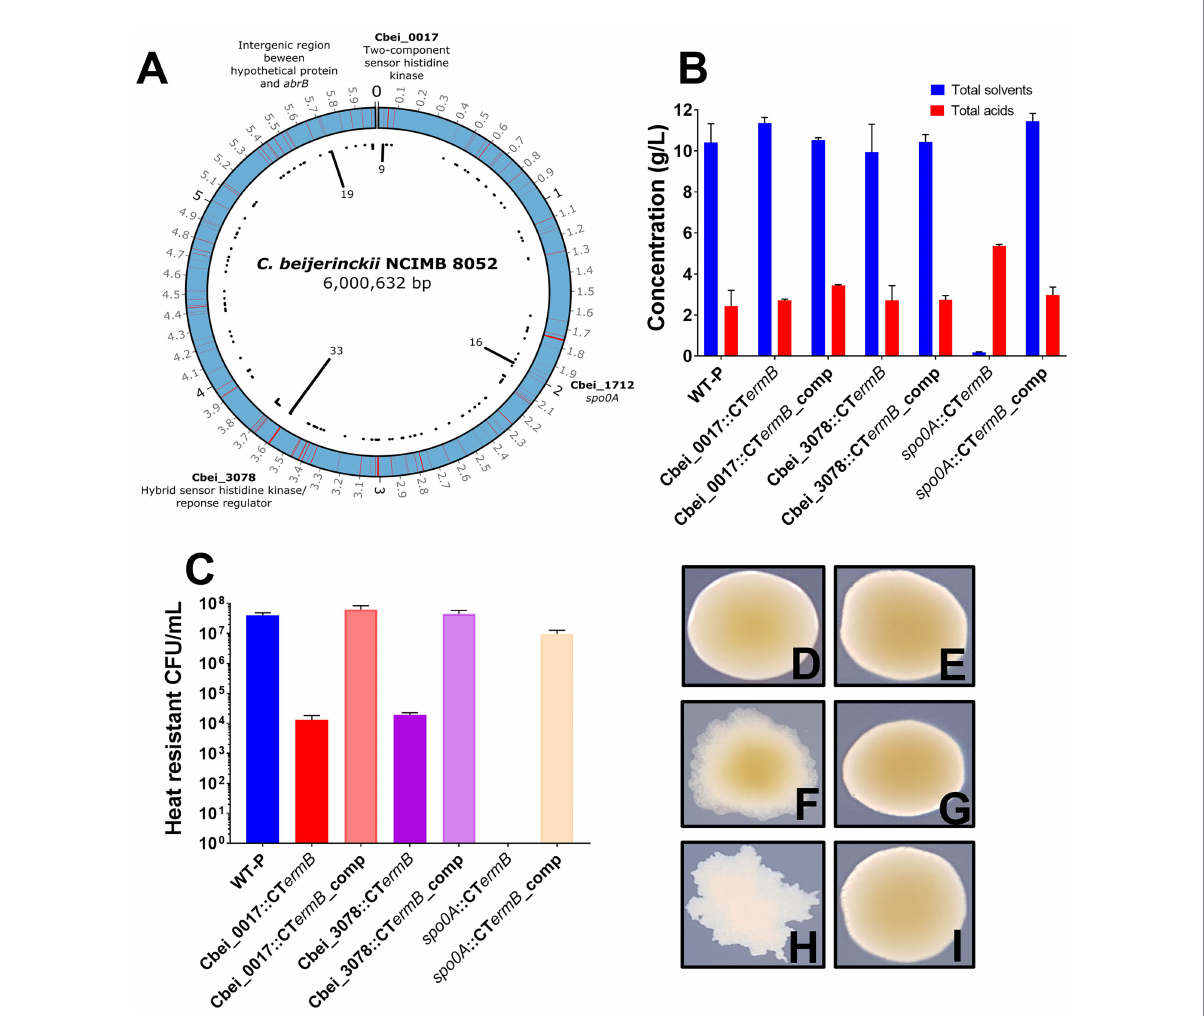
FIGURE 2 Genomic distribution of mutations in degenerate isolates and ClosTron mutant characterisation. (A) Image representing the distributions of mutations along the circular Clostridium beijerinckii NCIMB 8052 chromosome found for all degenerate isolates. Red lines indicate where a mutation was found and black lines in the centre of the image show the number of times that region was hit. Genomic regions that contained significantly more mutations than others are highlighted. (B) Fermentation products produced by spo0A, Cbei-0017 and Cbei_3078 ClosTron mutants and complemented strains. (C) Spores produced by ClosTron mutants and complemented strains. (D–I) ClosTron and complemented mutants colony morphotypes: (D) Cbei_0017 mutant, (E) Cbei_0017 complemented mutant, (F) Cbei_3078 mutant, (G) Cbei_3078 complemented mutant, (H) spo0A mutant and (I) spo0A complemented mutant. Error bars represent standard error of the mean (± SEM) of three independent experiments, each performed in technical